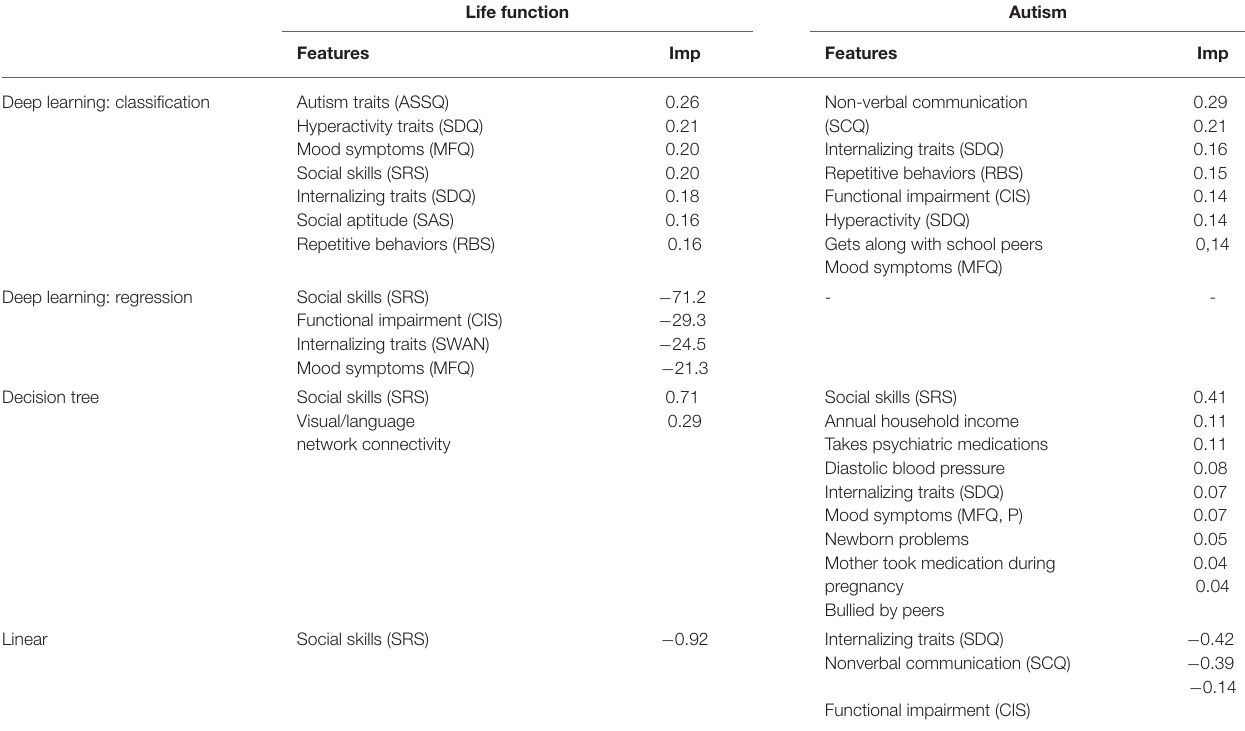
TABLE 5 | Optimized predictors of life function and autism.